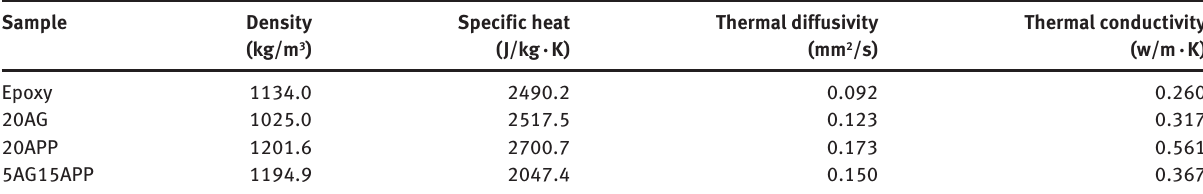
Table 4: Thermal properties of neat epoxy and its composites.